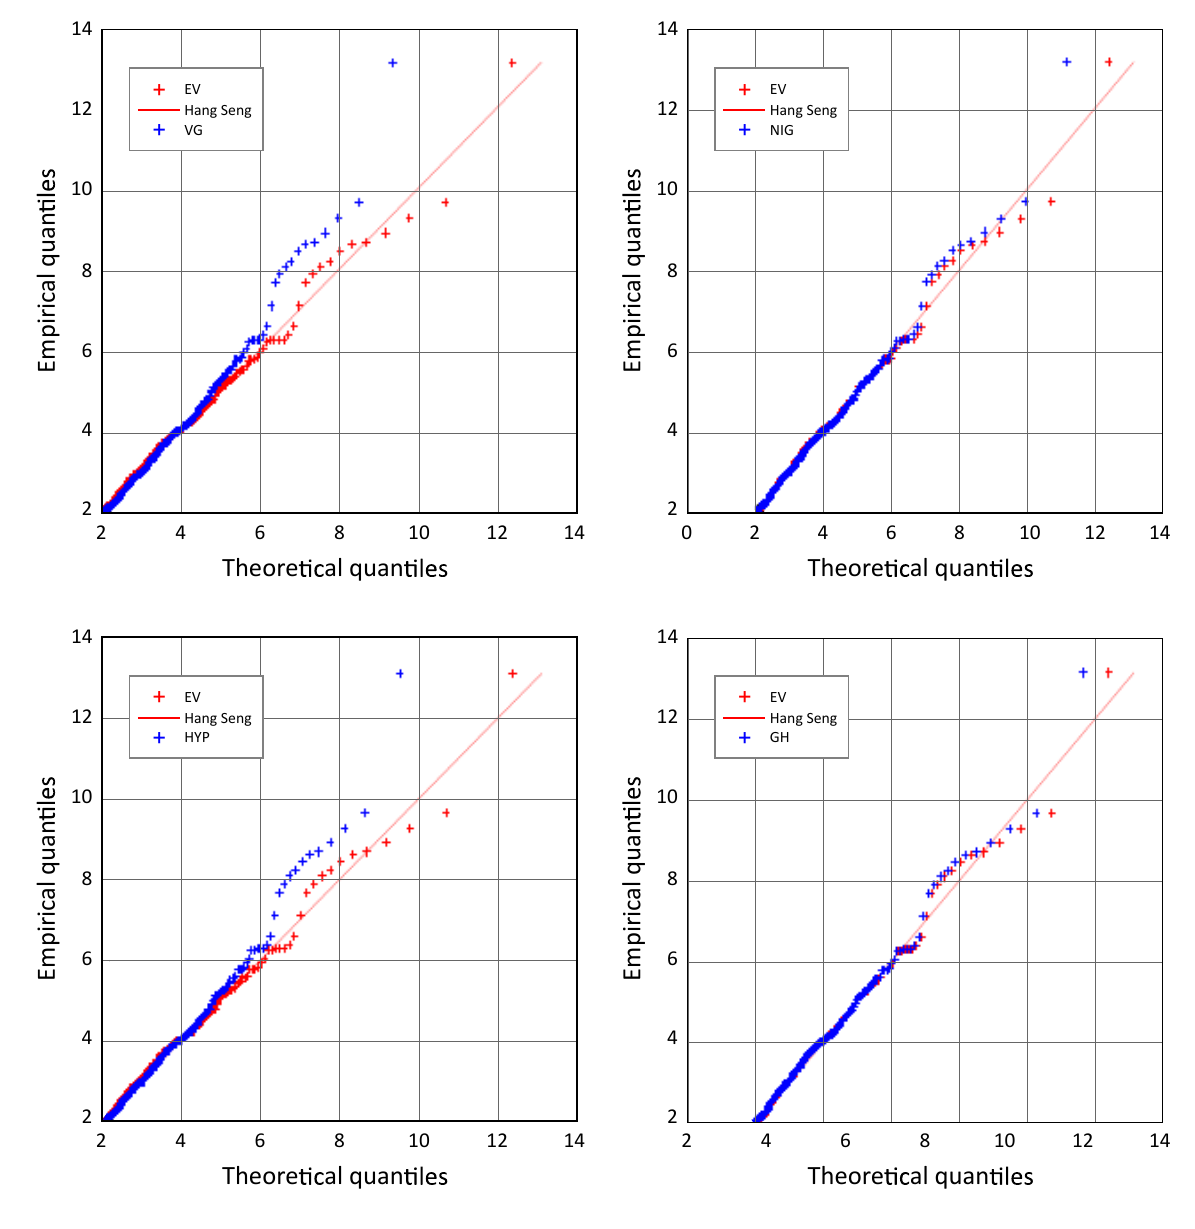
Figure 4. Conditional and unconditional quantiles in excess of threshold (2): long position in Hang